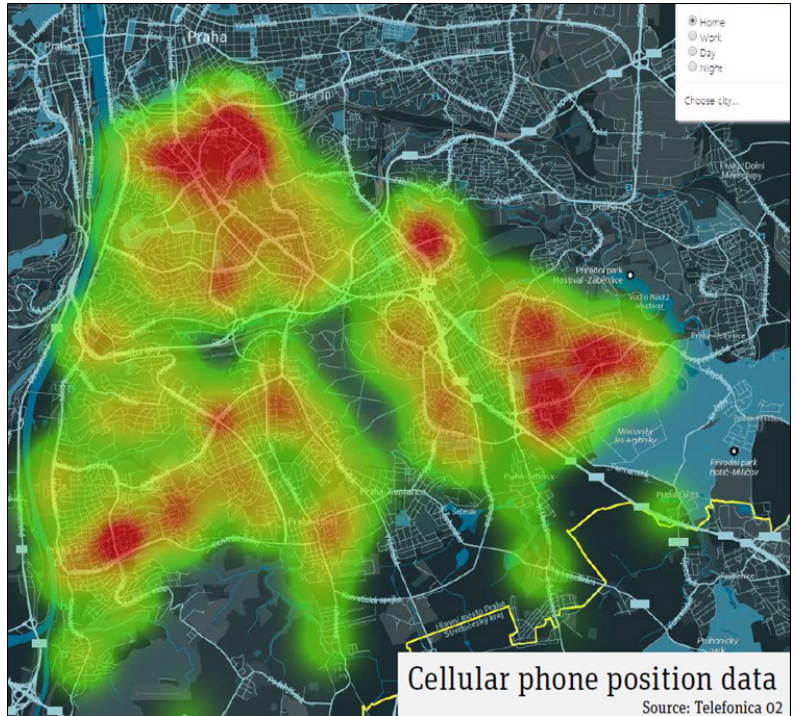
Figure 3. Example of geo-information product derived from near-real-time mobility service based on cell phone